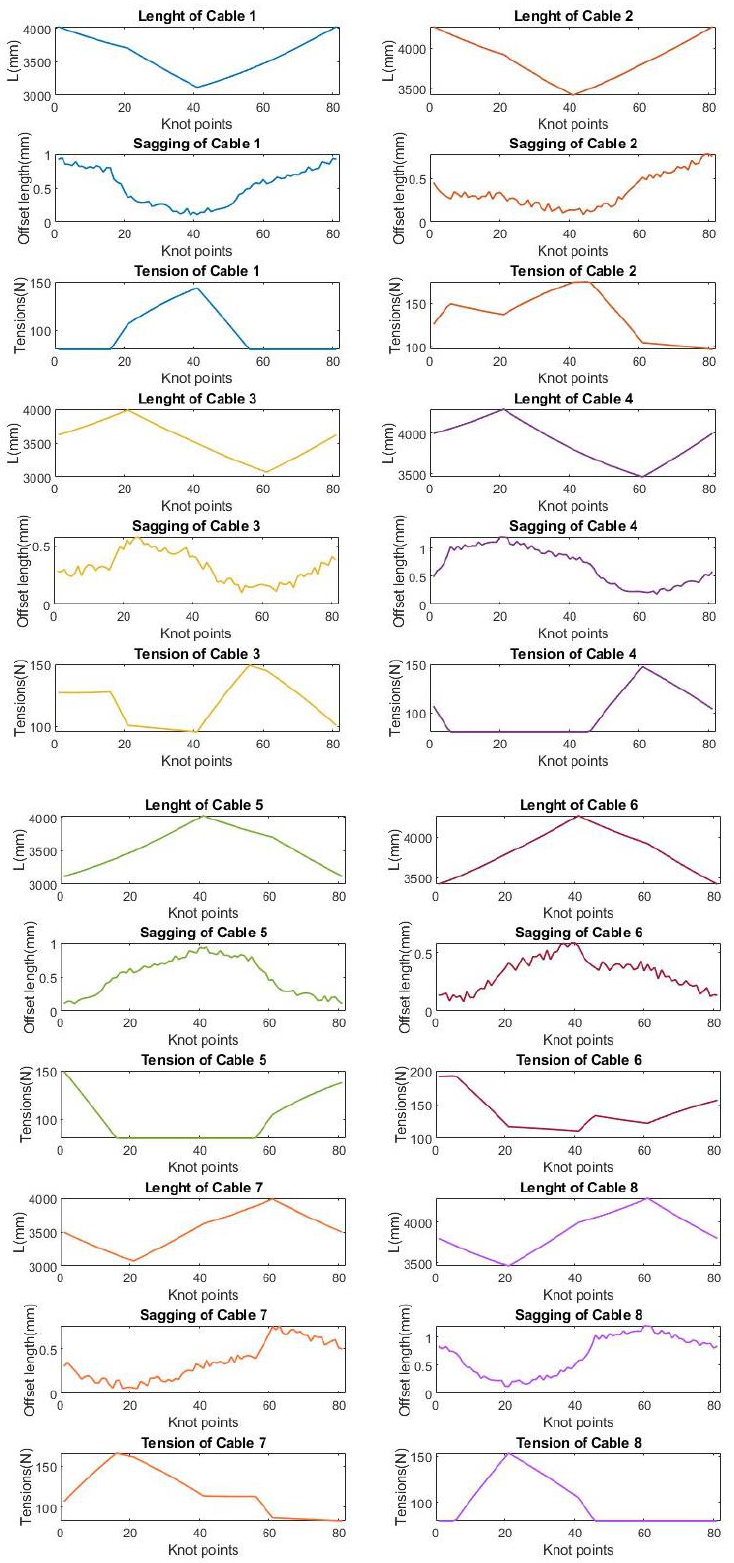
Figure 18. Offset length vs. tension and length of the cables for the 0.8 m square trajectory of the concrete.